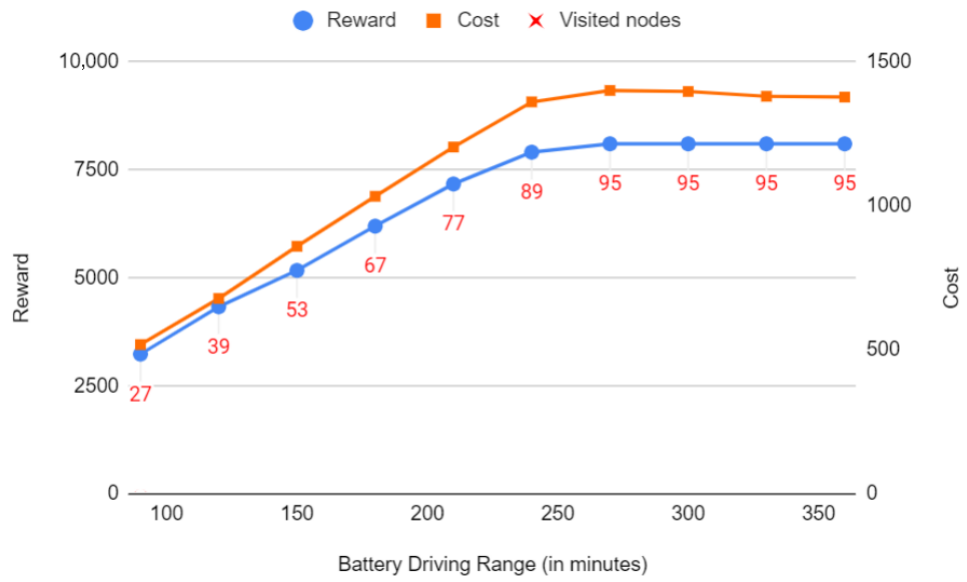
Figure 9. Effect of changing the driving range over three output variables using the E-TOP and E-VRP (if